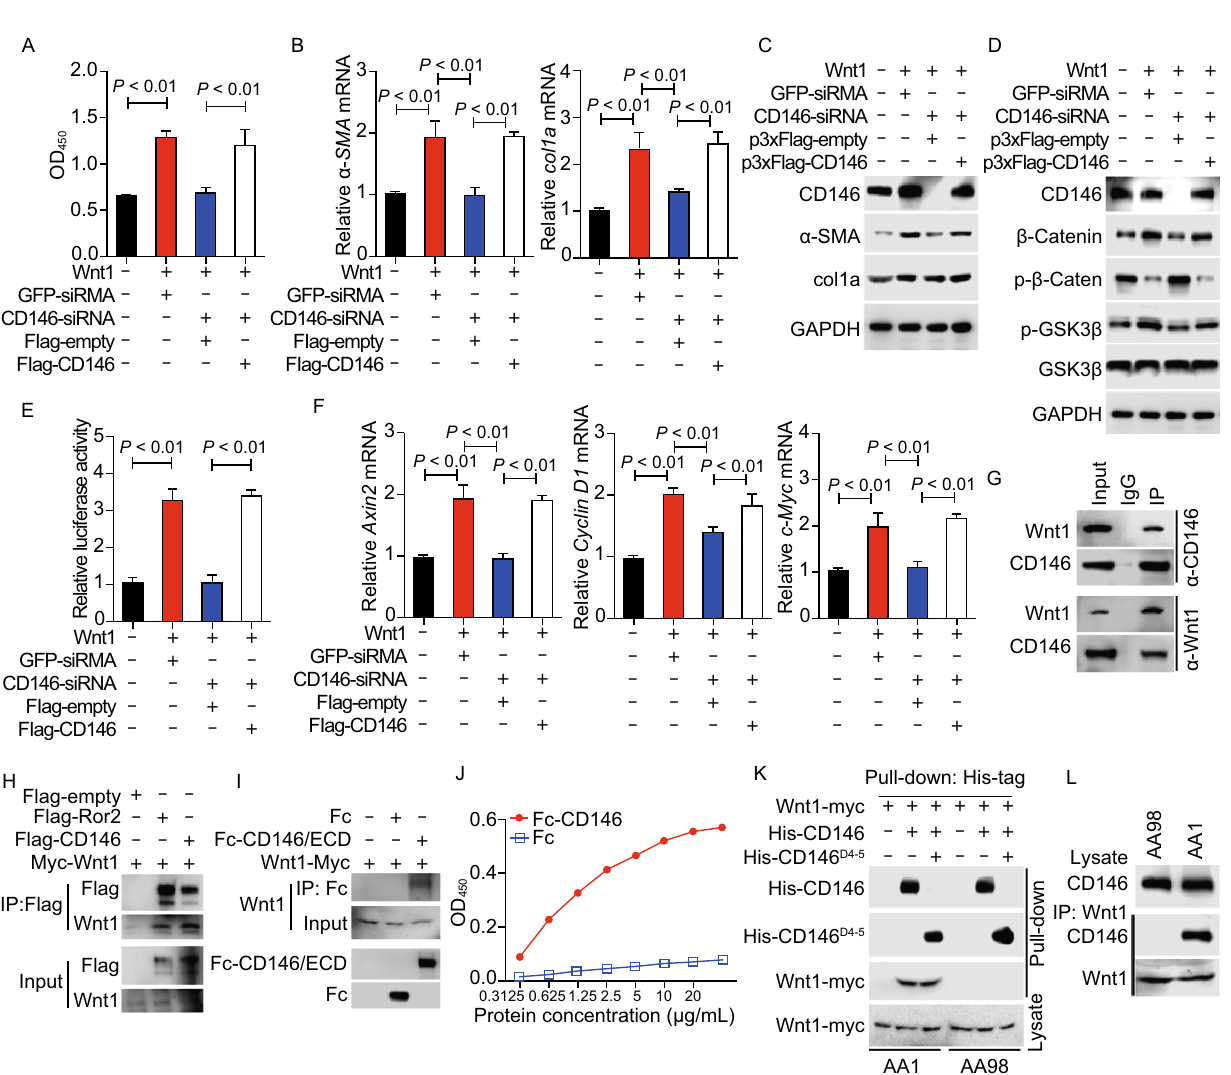
Figure 1. CD146 is required for fi broblast activation induced by canonical Wnt . (A) Human skin fi broblasts were transfected with CD146-siRNA and/or Flag-CD146. Cells were subjected to CCK-8 proliferation assays ( n = 8 per group). (B and C) RT-PCR or Western blot analysis of α -SMA and Col1a1 expression in human skin fi broblasts transfected with CD146-siRNA and/or Flag-CD146. (D) Western blot analysis of β -catenin and GSK3 β activation in the presence or absence of Wnt1 in fi broblasts transfected with CD146-siRNA and/or Flag-CD146. (E) TCF luciferase reporter assays to determine the role of CD146 expression in Wnt1/ β -catenin activation in human fi broblasts ( n = 5 per group). (F) RT-PCR analysis of Wnt1-induced expression of β -catenin target genes axin 2 , cyclin D1 and c-Myc in skin fi broblasts ( n = 5 per group). (G) Co-IP assays to test the association of endogenous CD146 with Wnt1 in human fi broblast cells. (H) Co-IP assays to test the association of Wnt1 with CD146 or Ror2 in HEK293 cells. Cells were co- transfected with Myc-Wnt1 and Flag-CD146. Proteins were precipitated using anti-Flag mAb M2. (I) Direct interaction between CD146 extracellular domain (CD146/ECD) and Wnt1 as determined by Fc pull-down assay. (J) CD146 binds Wnt1 directly in ELISA. The absorption values at 450 nm were measured. (K) Anti-CD146 AA98 blocked the Wnt1-CD146 interaction in His-tag pull-down assay. (L) The CD146 – Wnt1 interaction was blocked by AA98 but not by AA1 as measured in a co-IP